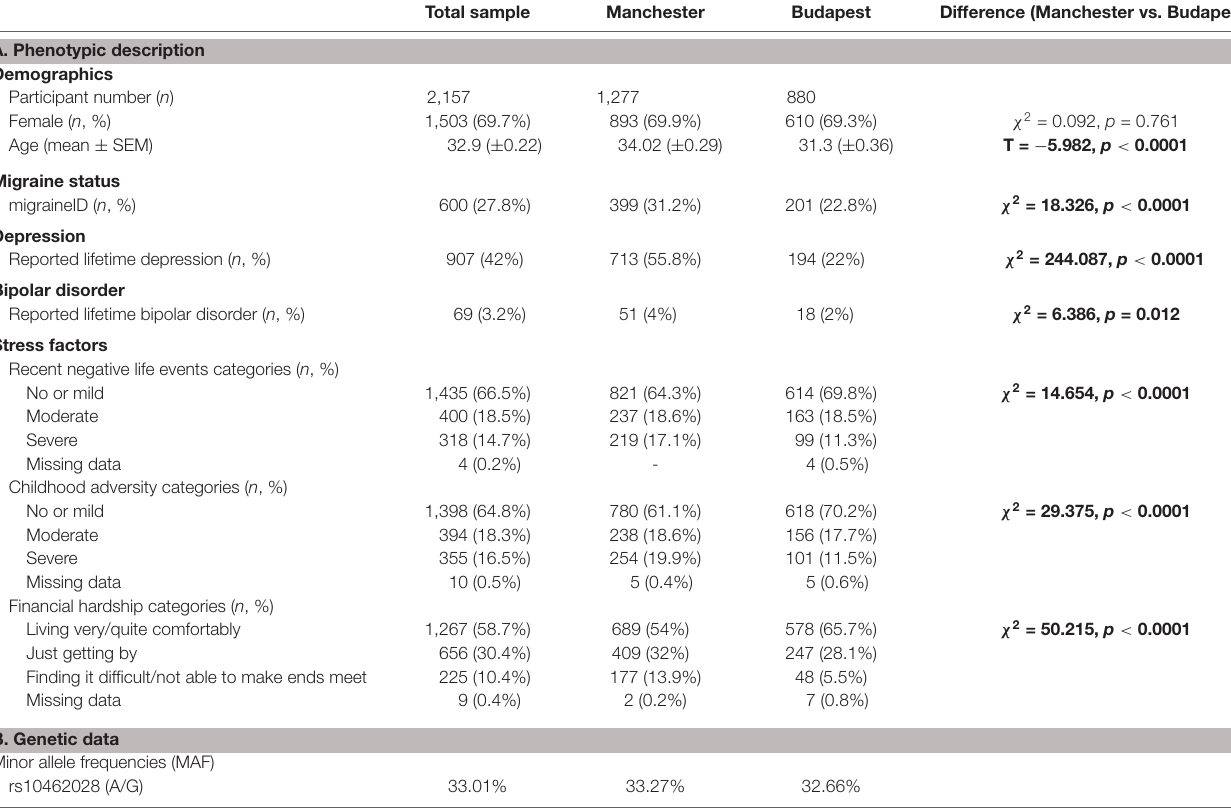
TABLE 1 | Details of the investigated samples and statistical results of the comparison between Manchester and Budapest subsamples. Total